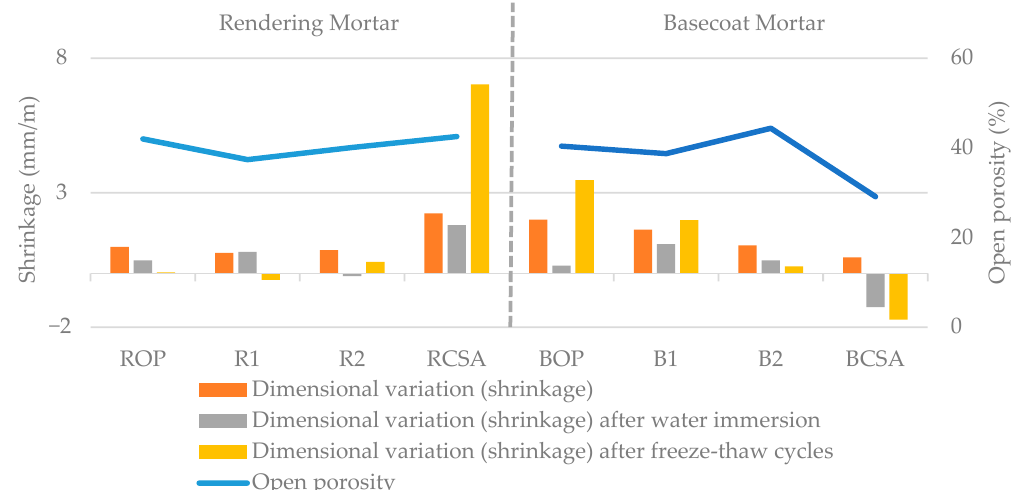
Figure 6. Shrinkage after normal, water immersion and freeze-thaw cycles curing conditions of rendering and basecoat mortars.